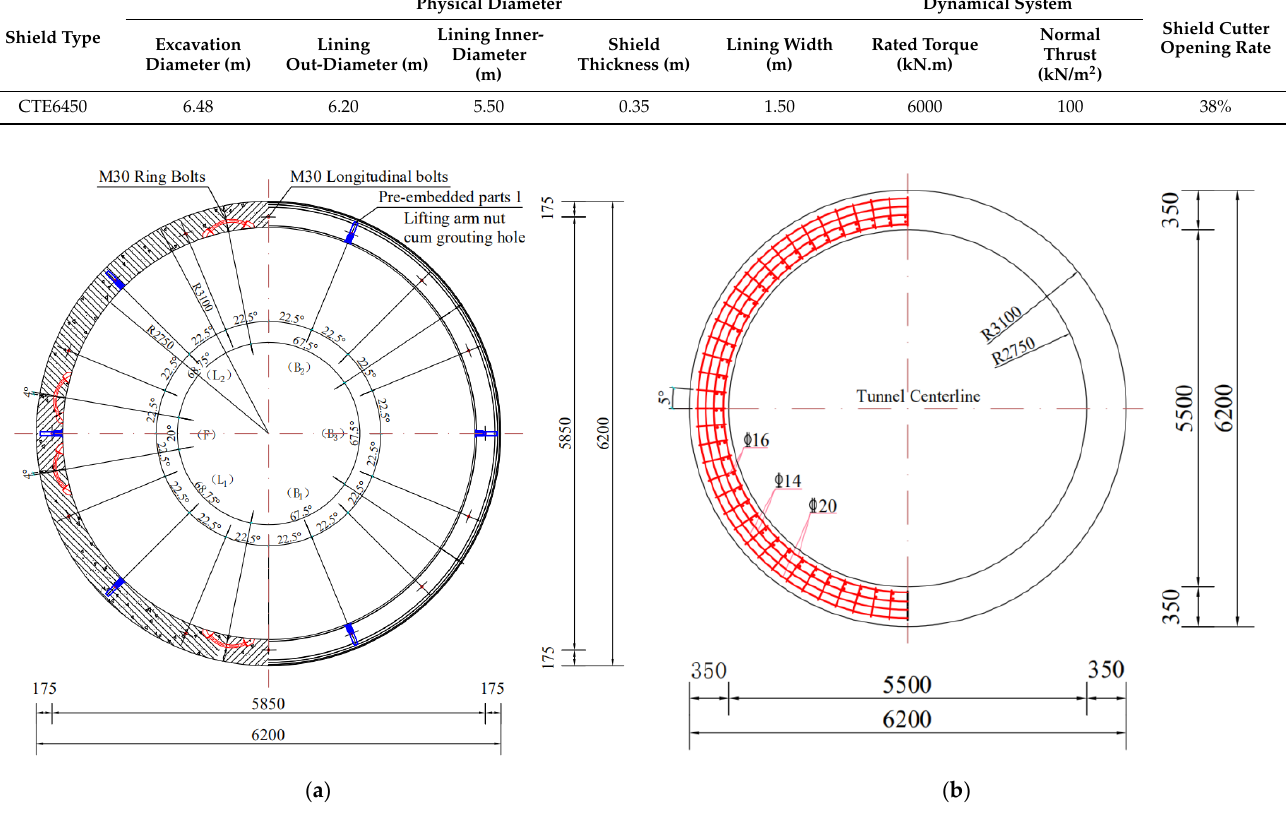
Figure 5. Illustration of lining ring: ( a ) lining divided (mm); ( b ) reinforcement of segment lining (mm). Table 3. Shield construction material Table 2. Geometric and technical parameters of the shield.